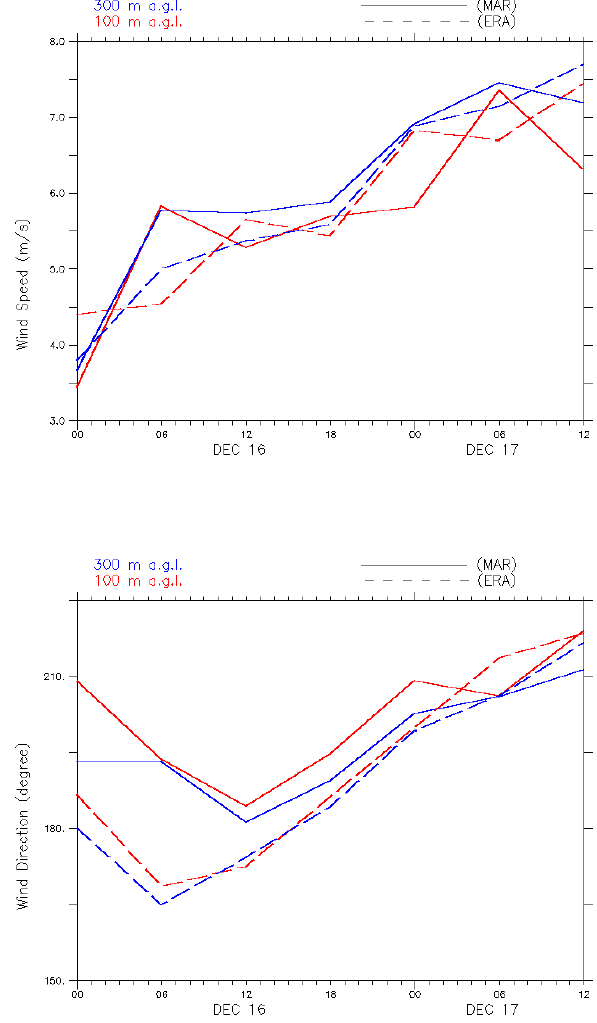
Figure 5. Comparison between the analysed wind speed (top) and direction (bottom) and the simulation, at 100m a.g.l. and 300m a.g.l. Note that Universal Time is